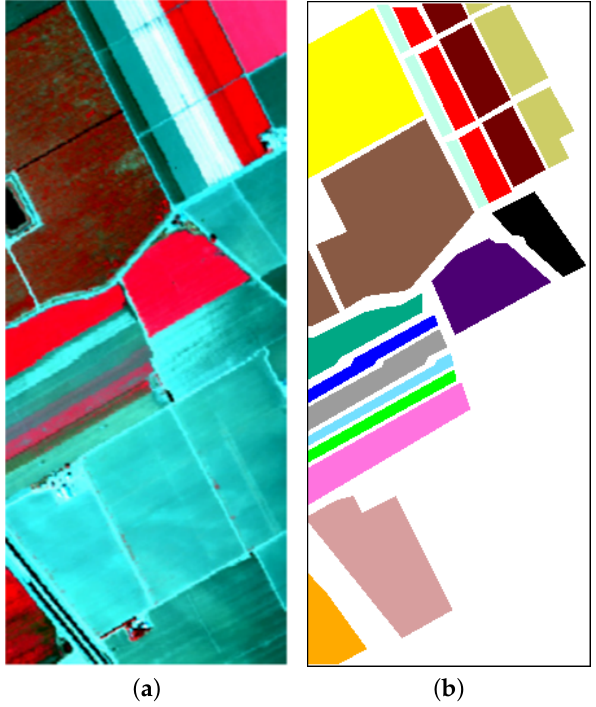
Figure 5. Salinas. ( a ) False-color image, ( b ) Ground-truth